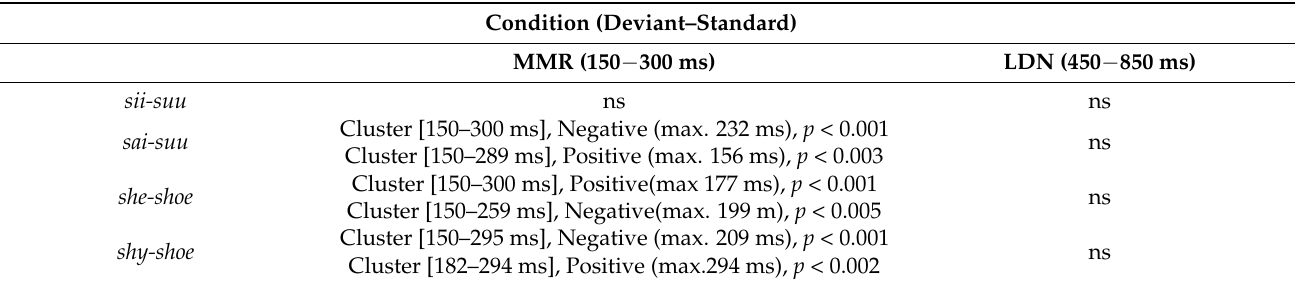
Table 4. Summary of the within RD group statistics using cluster-based permutation tests for the native (Finnish) and foreign (English)